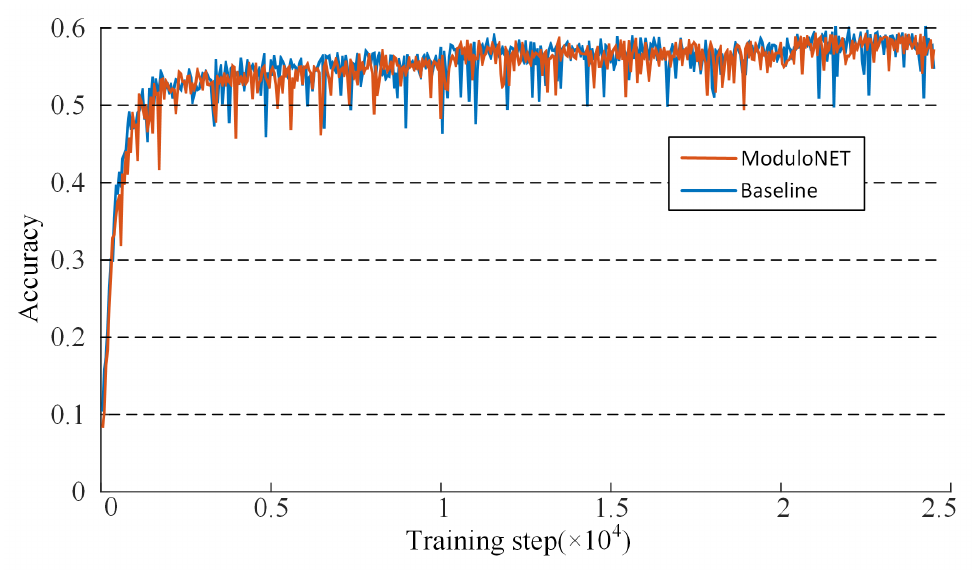
Figure 21: Test accuracy comparison of ConvNet with baseline vs. ModuloNET for the CIFAR100 dataset. The top-1 accuracy for ModuloNET only drop by 0.88% compared to that of the